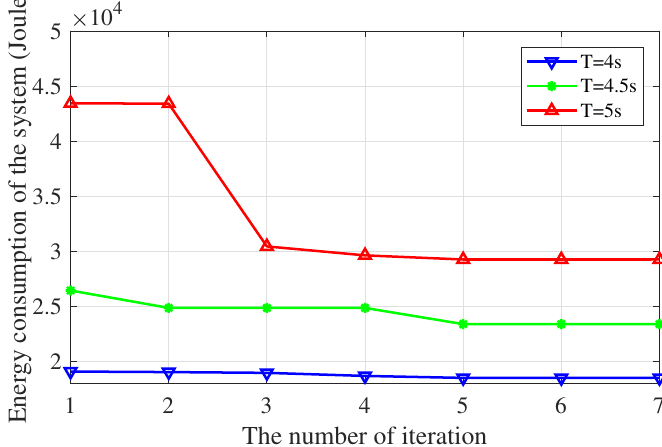
Figure 9. The total energy consumption of the system ( I 1 = 4 × 10 7 bits, I 2 = 5 × 10 7 bits, I 3 = 6 × 10 7 bits, I 4 = 7 × 10 7 bits and I 5 = 8 × 10 7